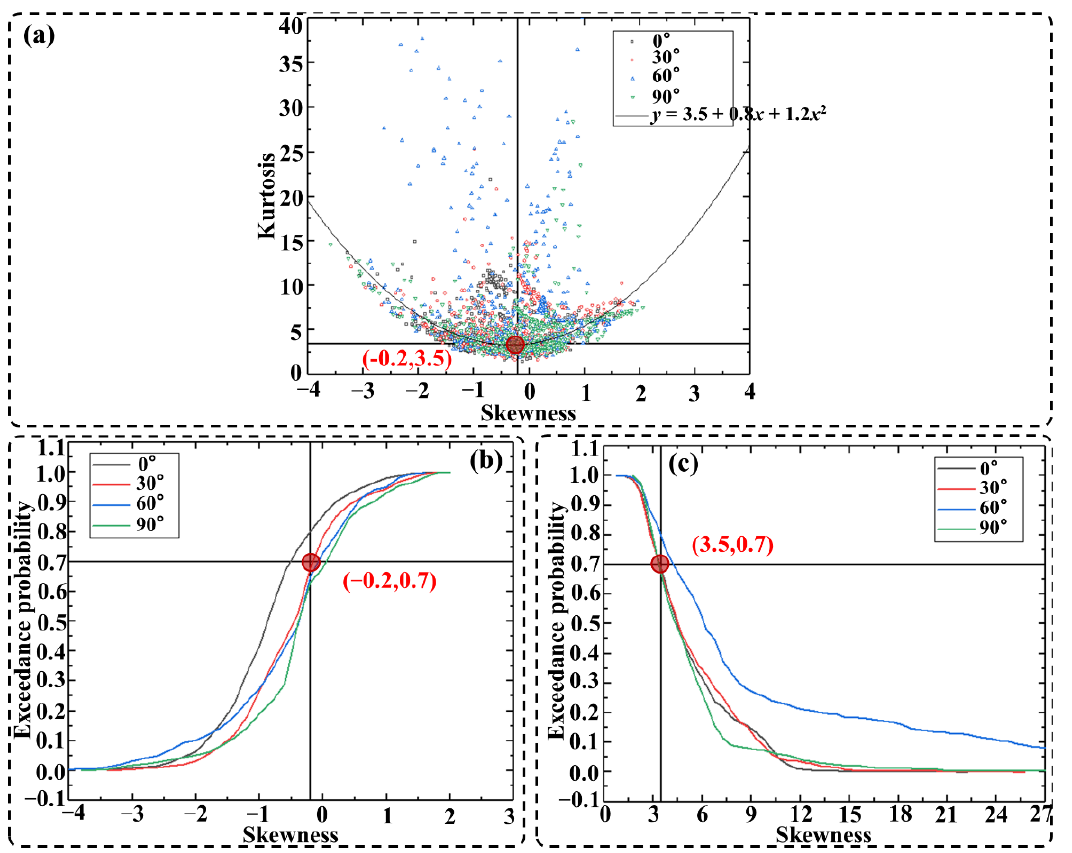
Figure 10. Results of curve fitting: ( a ) kurtosis and skewness; ( b ) beyond probability density of skewness; ( c ) beyond probability density of kurtosis.